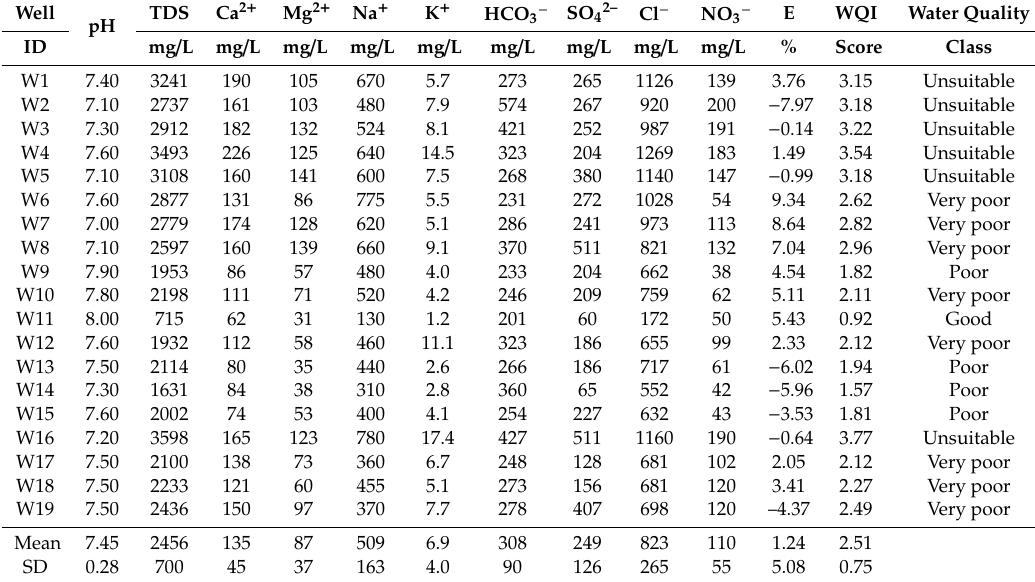
Table 3. Physio-chemical analysis of the groundwater samples taken in 2009; also given are the charge-balance error E , the WQI score, the water quality classification, and the mean and standard deviation (SD).